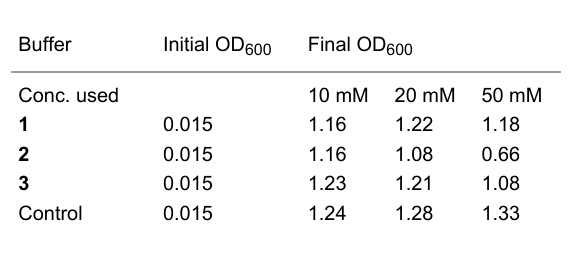
Table 2: OD 600 of cultures with varying concentrations of amino-